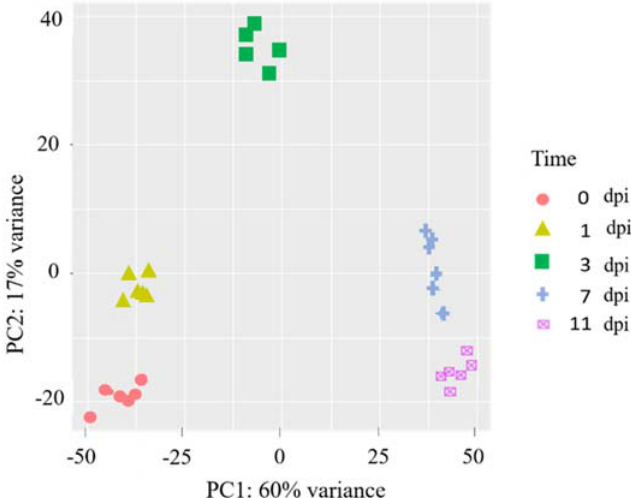
Figure 2. Principal components (PC) of RNA-seq expression profile obtained for Leptosphaeria maculans in planta. PC analysis shows RNA-seq expression profile of both UMAvr7 (with AvrLm7 ) and umavr7 (mutant of AvrLm7 ) of L. maculans in in planta samples of both hosts: 01-23-2-1 (Rlm7 line) and Westar (no R genes) at 0-, 1-, 3-, 7-, and 11-days post inoculation. The colors used were the same for both isolates at each time point. x -axis, PC1; y -axis, PC2. The proportion of variance for each PC is indicated in axis titles. Dots in the same color are three replicates of each isolate for each time point. Results were representative of three biological replicates.